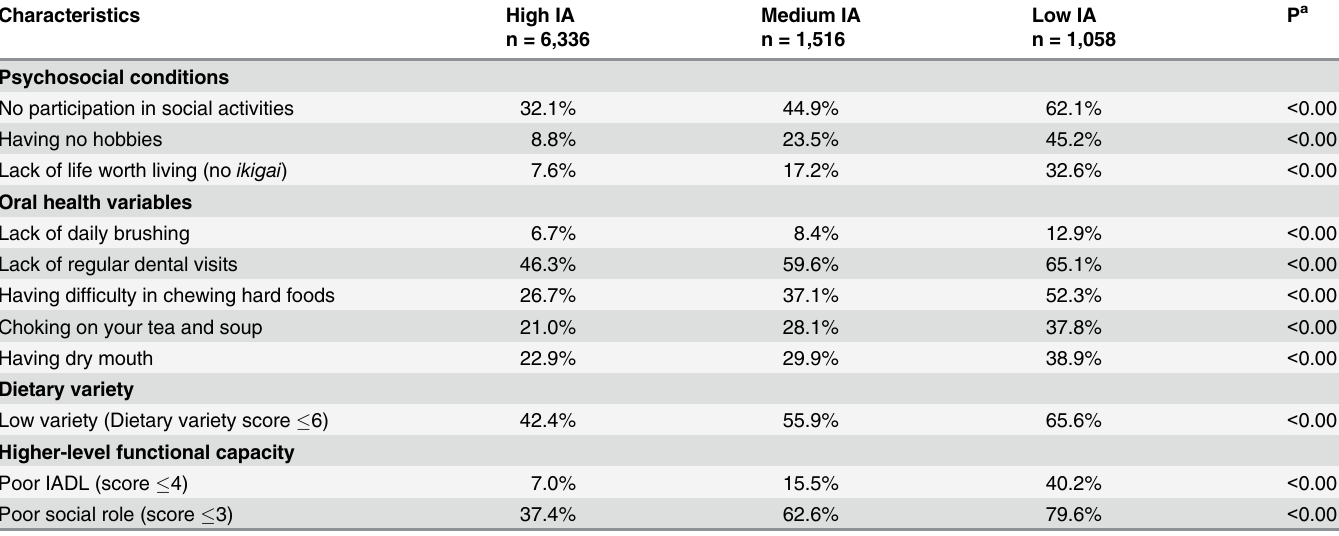
Table 3. Psychosocial Conditions, Oral Health, Dietary Variety, and Higher-level Functional Capacity of Participants Stratified by the Level of Intel- lectual